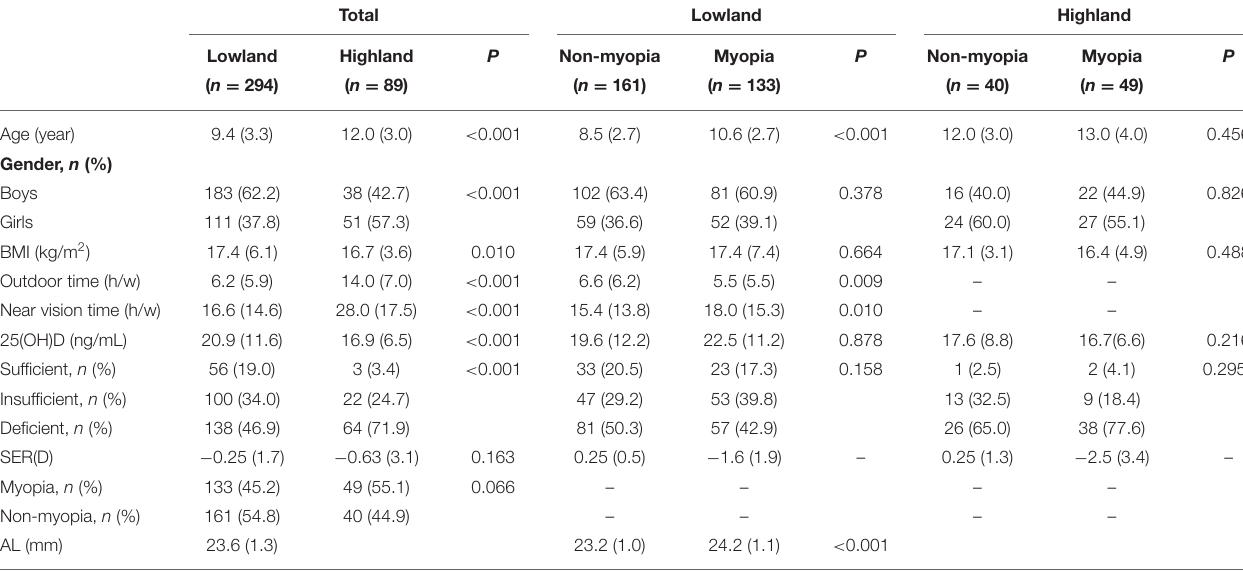
TABLE 1 | Demographic information of subjects in lowland and highland area *